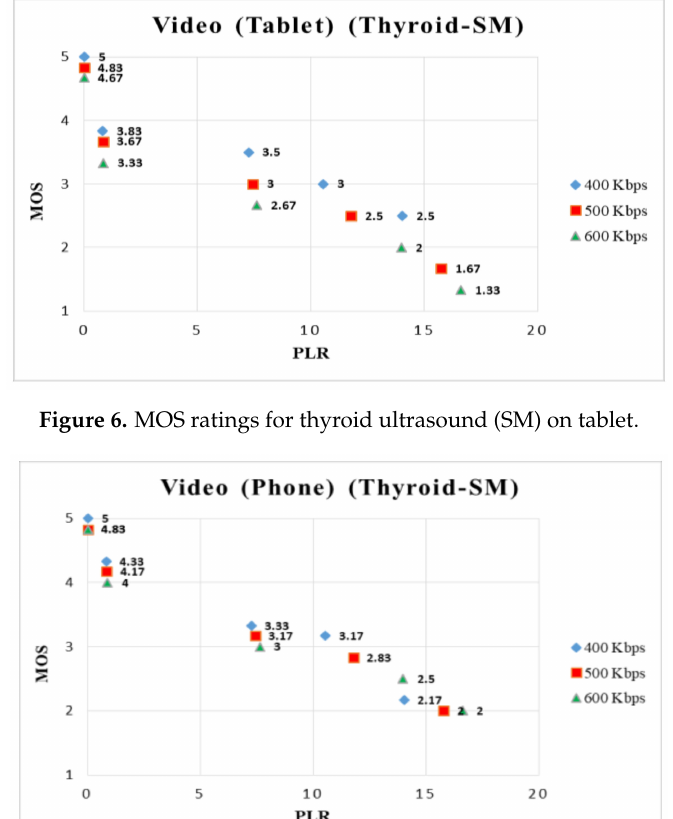
Figure 5. MOS ratings for thyroid ultrasound (SM) on laptop.